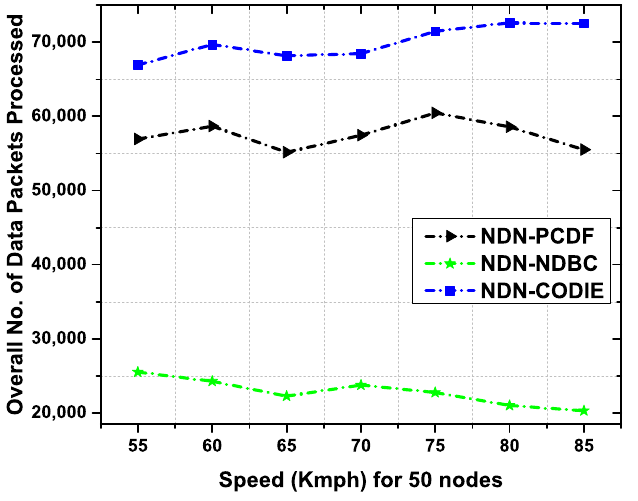
Figure 13. Overall number of data packets processed as a function of vehicle